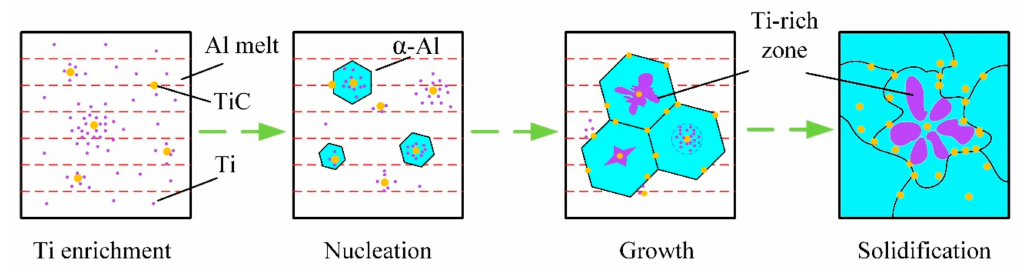
Figure 7. The schematic diagram of the nucleation and growth process of α